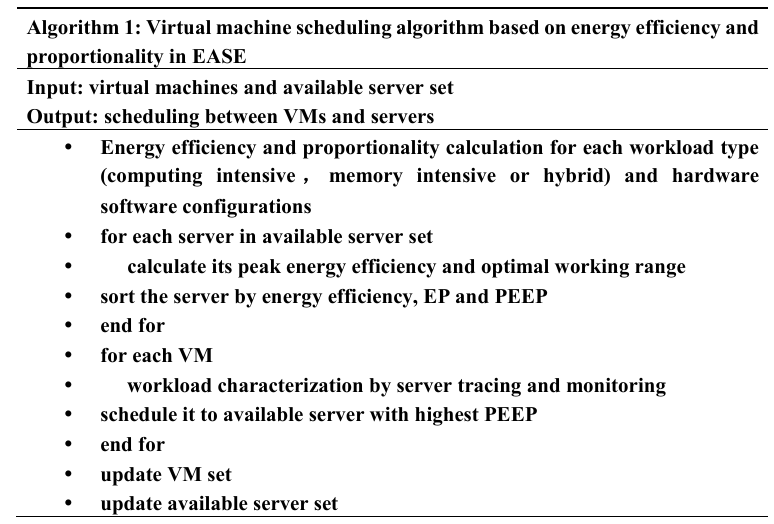
Figure 10. VM scheduling in EASE.